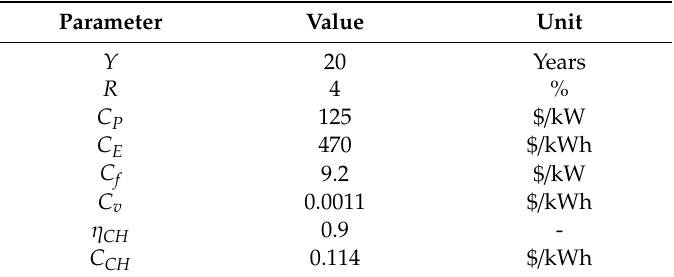
Table 12. Parameter for the economic evaluations.